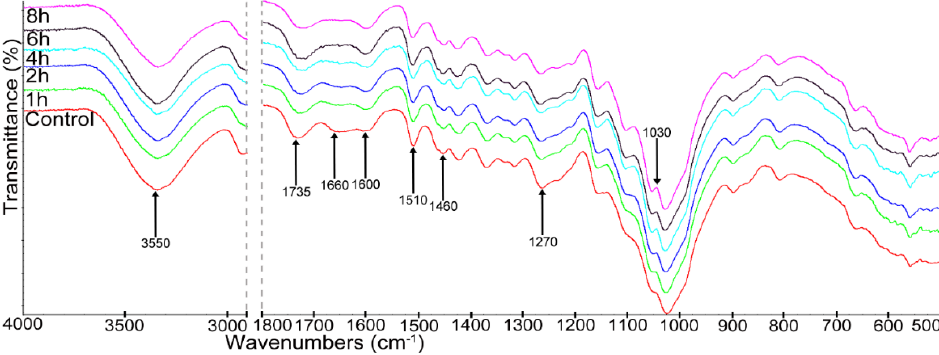
Figure 4. ATR-FTIR spectra of control and heat-treated wood.